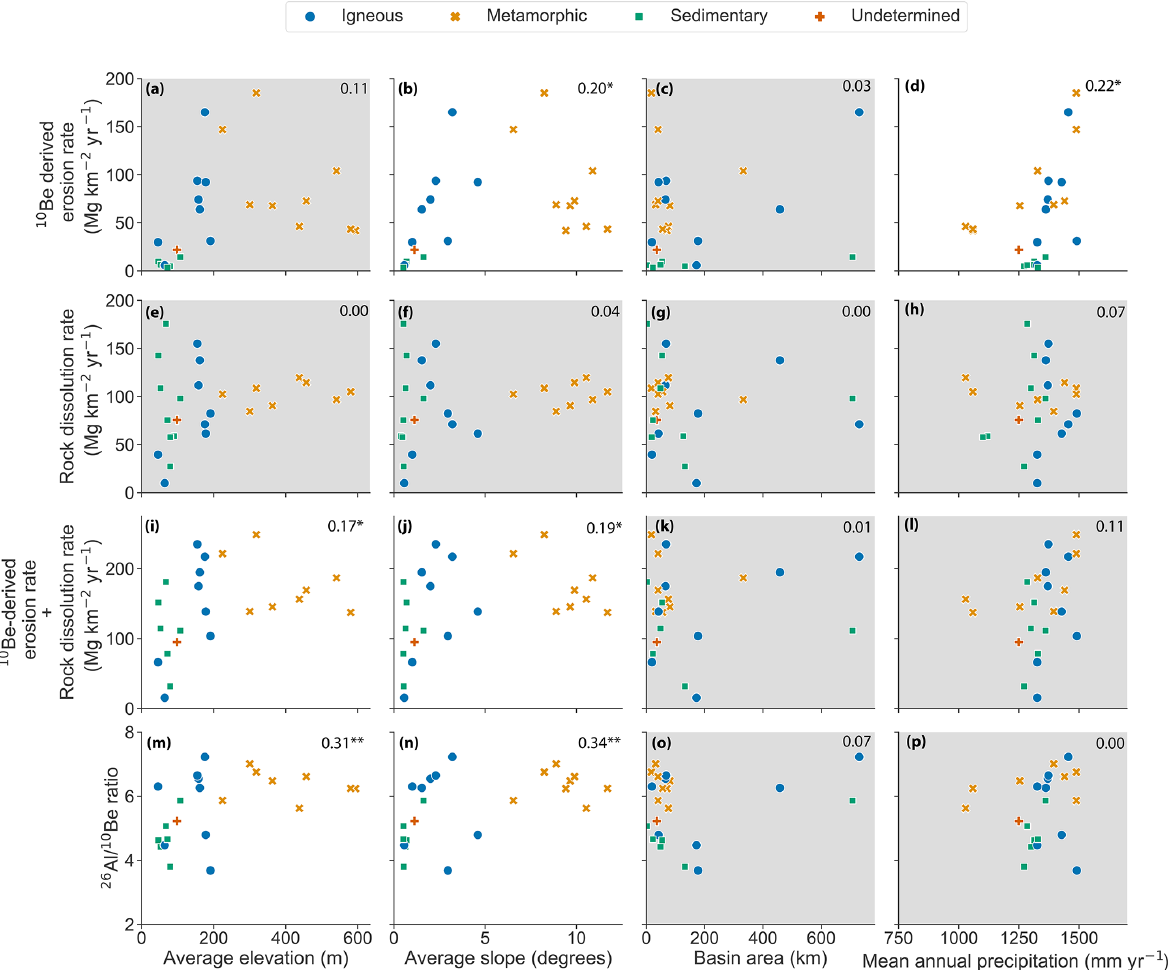
Figure 6. Relationship of measured 10 Be-derived erosion rates, chemical denudation rates, and the sum of chemical denudation rates and 10 Be-derived erosion rates to basin characteristics. Differently shaped and colored points represent the dominant underlying rock type in that basin. Plots with p > 0.05 are shown with a gray background. Small numbers in the upper right are R 2 values; ∗ indicates p ≤ 0.05, ∗∗ p <